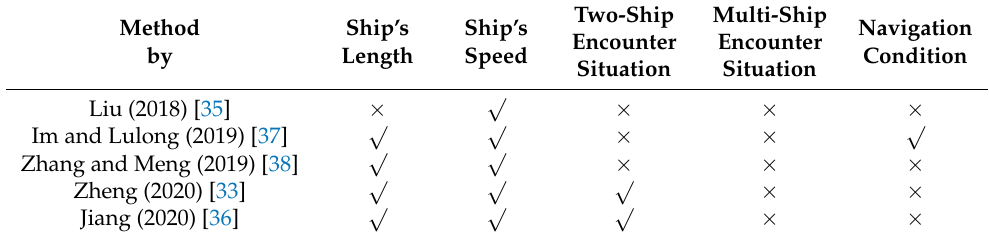
Table 1. Some related factors taken into account in various